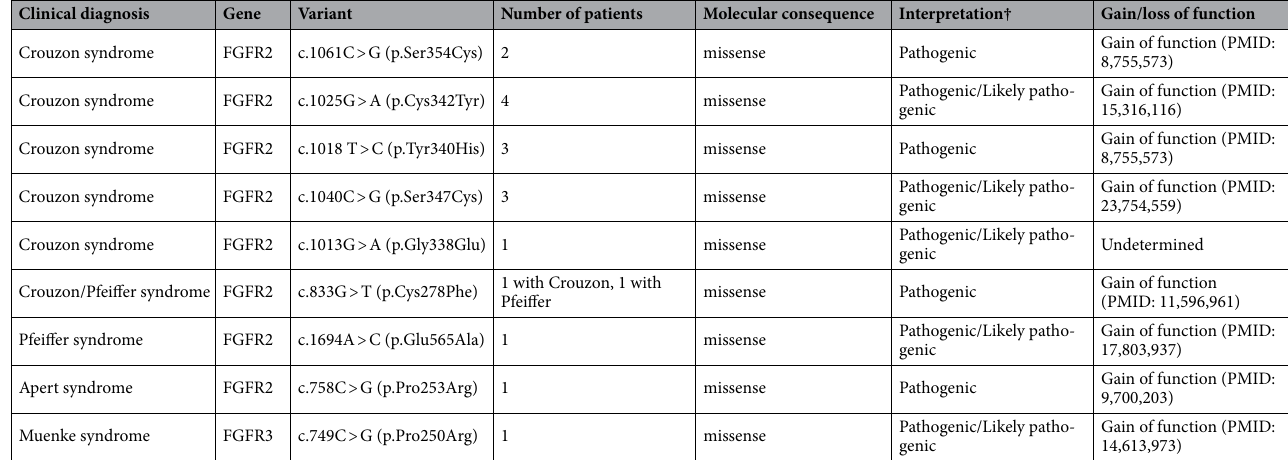
Table 1. Genetic features of patients with syndromic craniosynostosis associated with fibroblast growth factor receptor mutation. FGFR, fibroblast growth factor receptor. † Classification according to 2015 American College of Medical Genetics and Genomics and the Association for Molecular Pathology